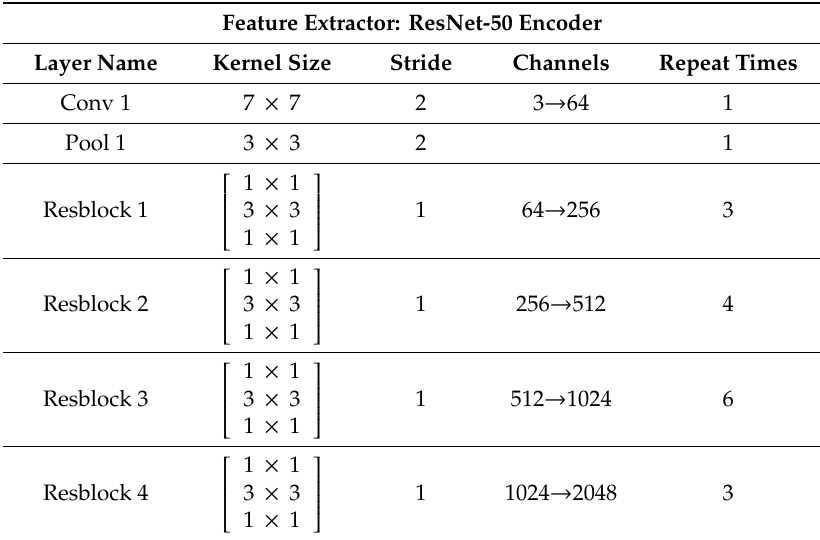
Table 2. Architecture of feature extractor in our pattern classification model.